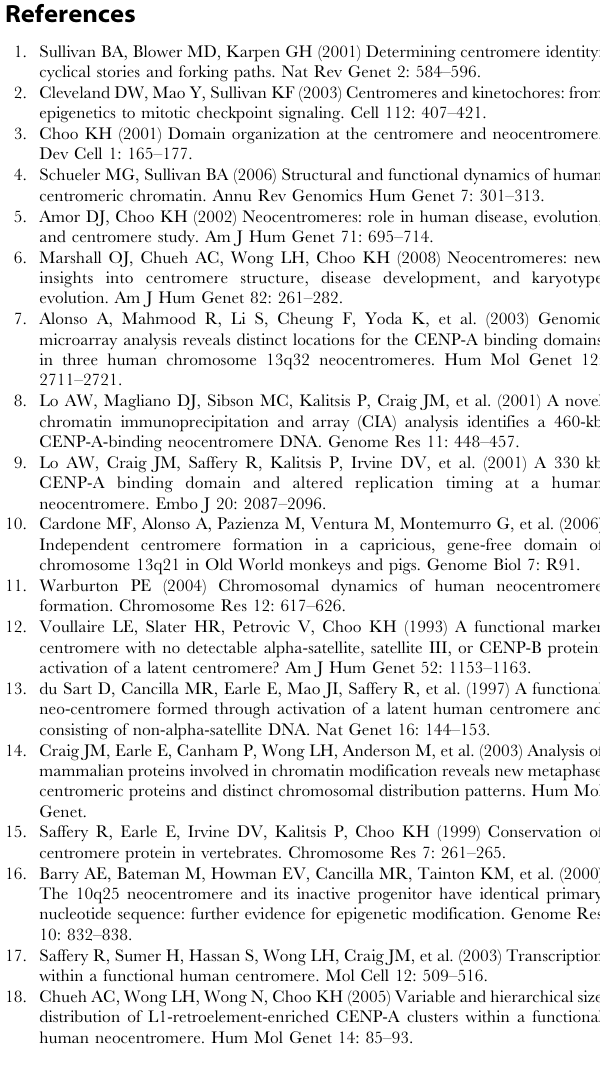
Table S1 Sequence characteristics of L1s across a 6-Mb genomic region of the 10q25 neocentromere.